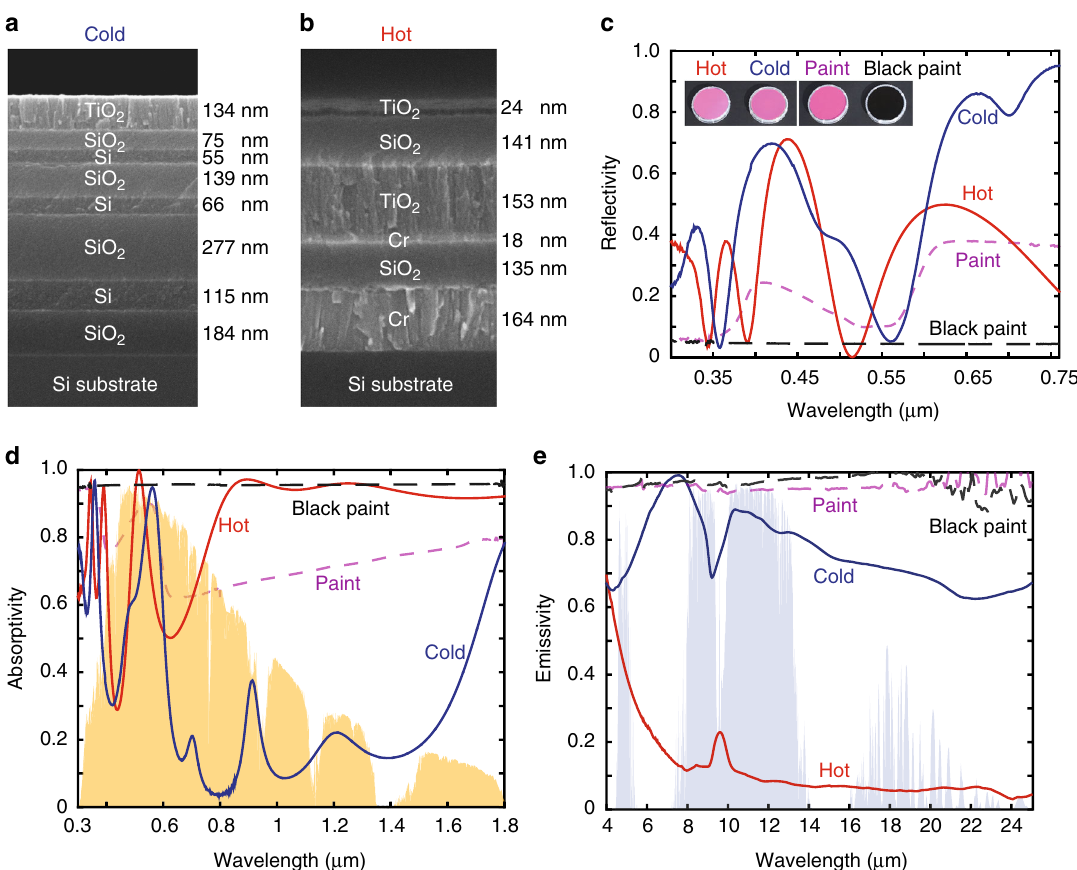
Fig. 3 Experimental realizations of two surfaces with same colour but very different radiative thermal loads. a , b Cross-section scanning electron microscopy images of the ‘ cold ’ ( a ) and ‘ hot ’ ( b ) photonic structures, with the materials and thickness of each layer. Both of the samples are deposited on 500- μ m-thick, 100-mm-diameter silicon wafers. c Re fl ectivity spectra of the ‘ cold ’ (blue curve) and ‘ hot ’ (red curve) photonic structures in the visible range demonstrating metamerism. The re fl ectivity spectra of a commercially available pink paint with similar colour (dashed purple curve) and a black paint (dashed black curve) are also plotted for references. Inset photos show from left to right the ‘ hot ’ , ‘ cold ’ , pink paint, and the black paint sample, respectively. d Absorptivity spectra of the ‘ cold ’ (blue curve) and ‘ hot ’ (red curve) photonic structures, the pink paint (dashed purple curve) and the black paint (dashed black curve) samples in the solar wavelength range, with the normalized AM1.5 solar spectrum plotted as the yellow shaded areas. e Emissivity spectra of the ‘ cold ’ (blue curve) and ‘ hot ’ (red curve) photonic structures, the pink paint (dashed purple curve) and the black paint (dashed black curve) samples over the infrared wavelength, with atmosphere transmittance 28 plotted as the light blue shaded area for